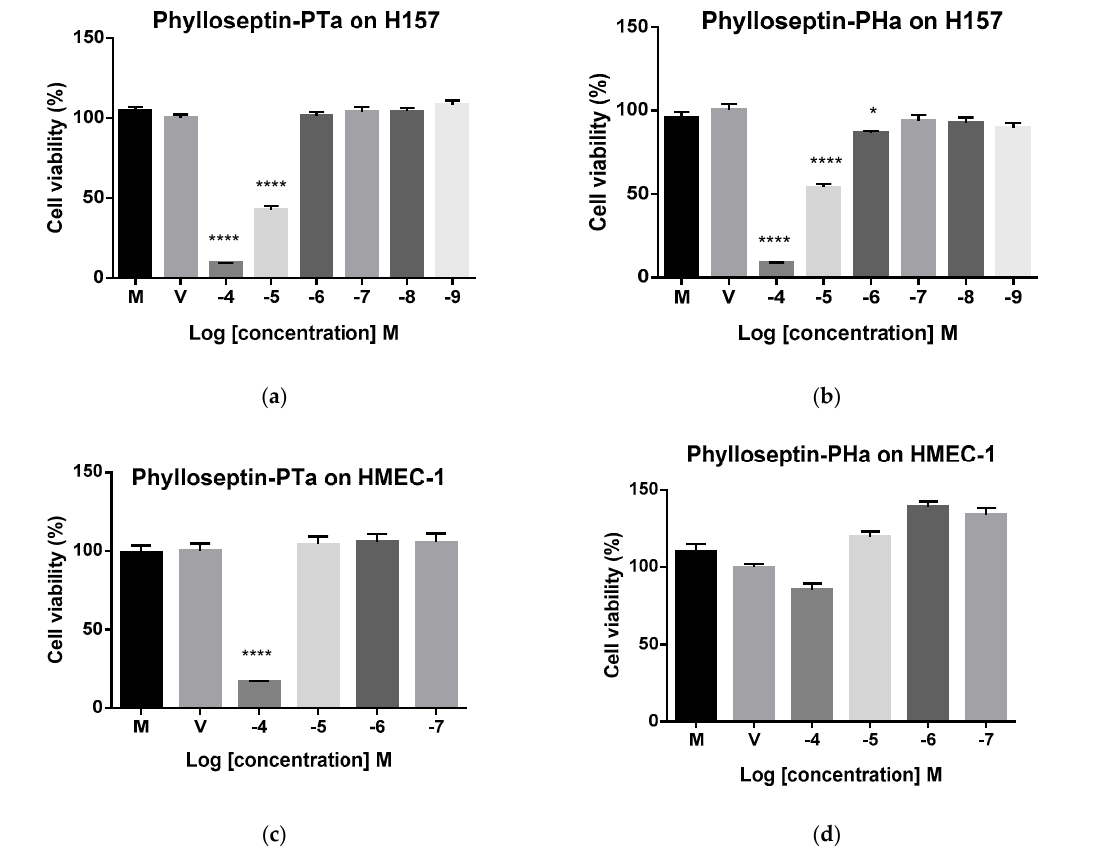
Figure 10. Anti-proliferative effects of purified synthetic ( a ) phylloseptin-PTa and ( b ) phylloseptin-PHa on non-small cell lung cancer cells H157, and purified synthetic ( c ) phylloseptin-PTa and ( d ) phylloseptin-PHa on human microvessel endothelial cells HMEC-1 after 24 h incubation. Data represent means ± SEM of three independent experiments with five replicates. M represents cells in medium, V represents cells in 1% DMSO medium as the vehicle control. **** p < 0.0001, * p < 0.05 by one-way analysis of variance followed by Dunnett’s multiple comparisons tests with vehicle control group.